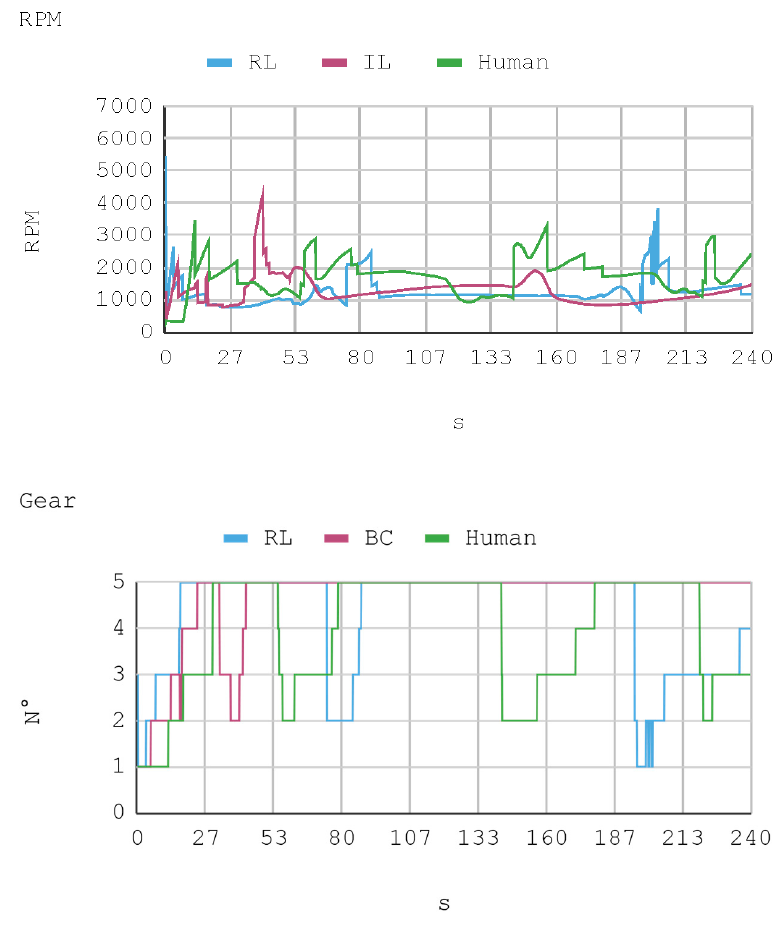
Figure 11. Case 1. Automobile’s revolutions per minute and gear number.